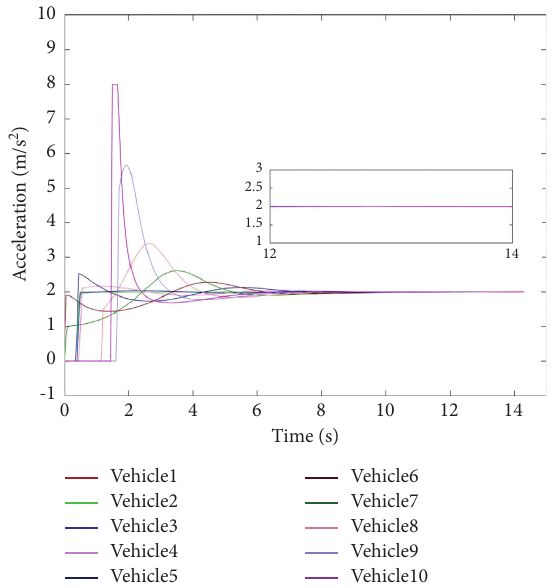
Figure 6: Acceleration history under proposed controller